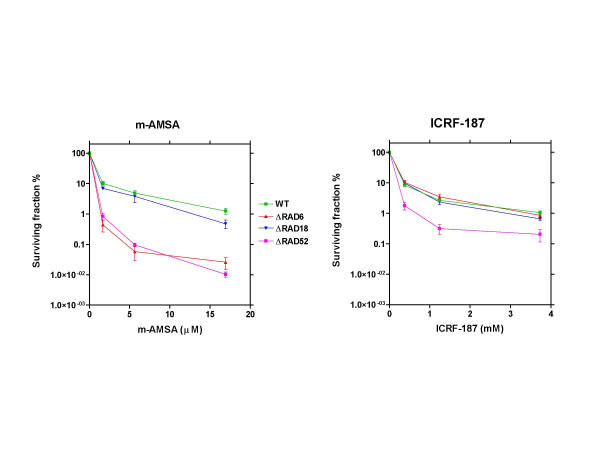
Clonogenic sensitivity of PRR defective Δrad6 and Δrad18 yeast cells towards equitoxic doses of ICRF-187 and m-AMSA. A Δrad52 strain is included for comparison. Error-bars represent SEM of at least 3 experiments.